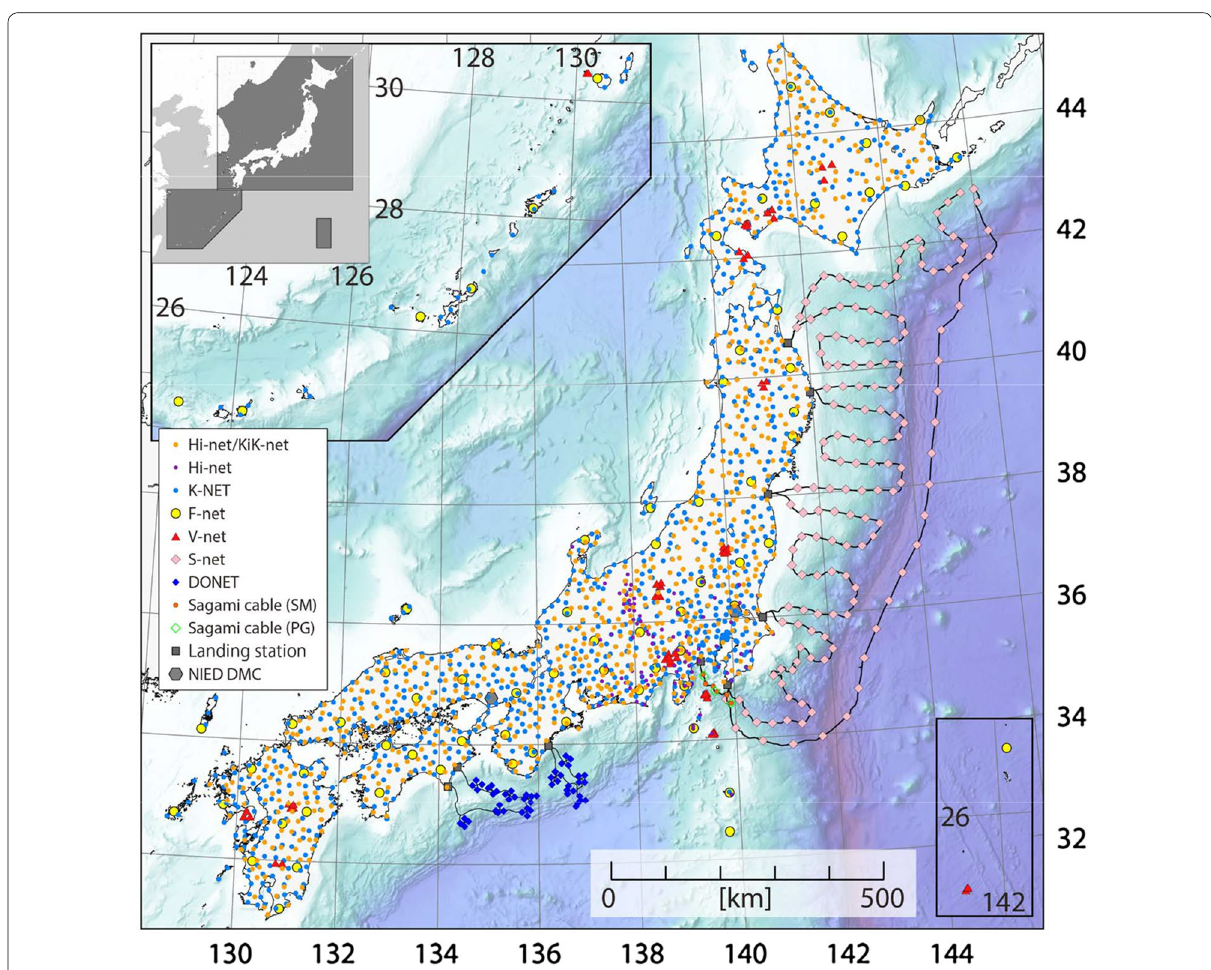
Fig. 1 MOWLAS station distribution for the three regions of the inset map. SM and PG indicate seismometers and pressure gauges,